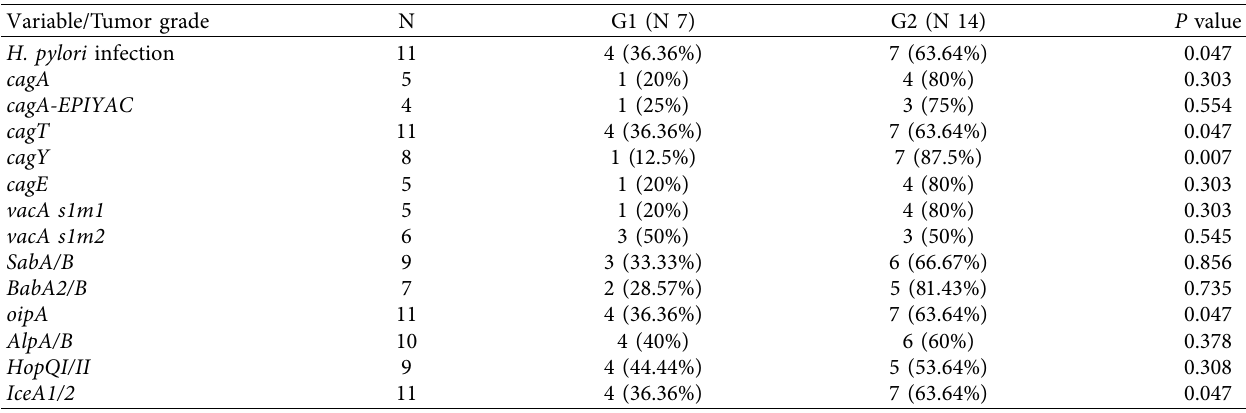
Table 6: Frequency of H. pylori virulence genes’ cDNA in gastric carcinoma biopsy samples with G1 and G2 tumor grades. All samples with G3 and G4 tumor grades were without H. pylori